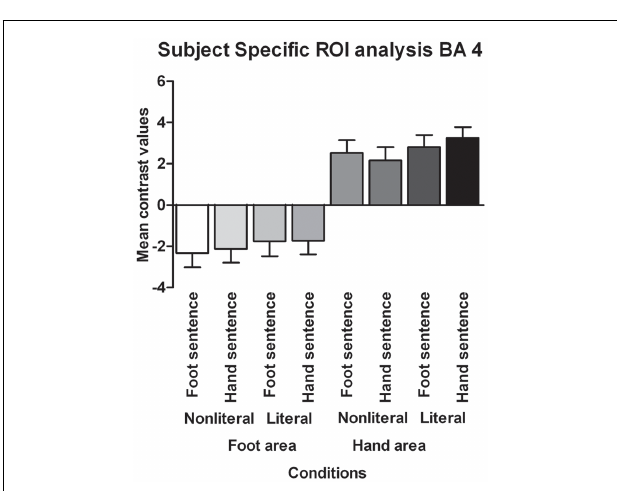
FIGURE 3 | Functionally defined, subject-specific ROI analysis for the foot area and hand area in BA 4. The mean contrast values compared to an implicit baseline are shown for each sentence type and extremity.